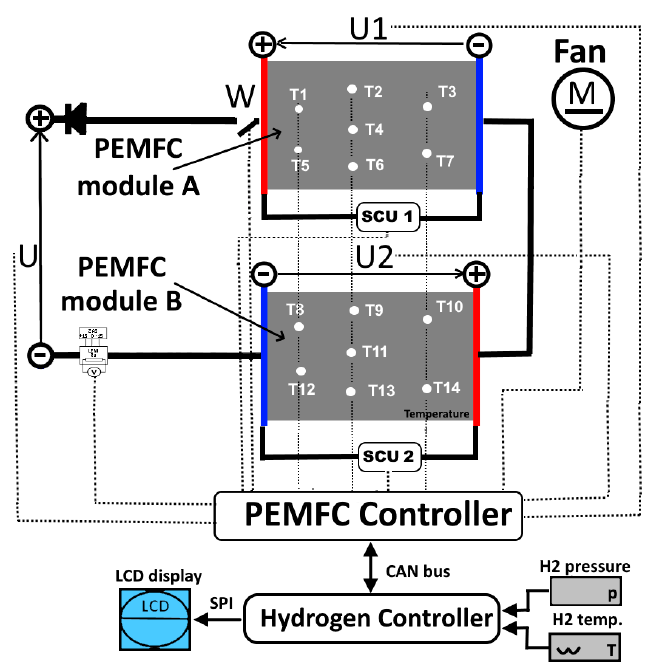
Figure 2. A 10 kW PEMFC stack with PEMFC controller and hydrogen unit.